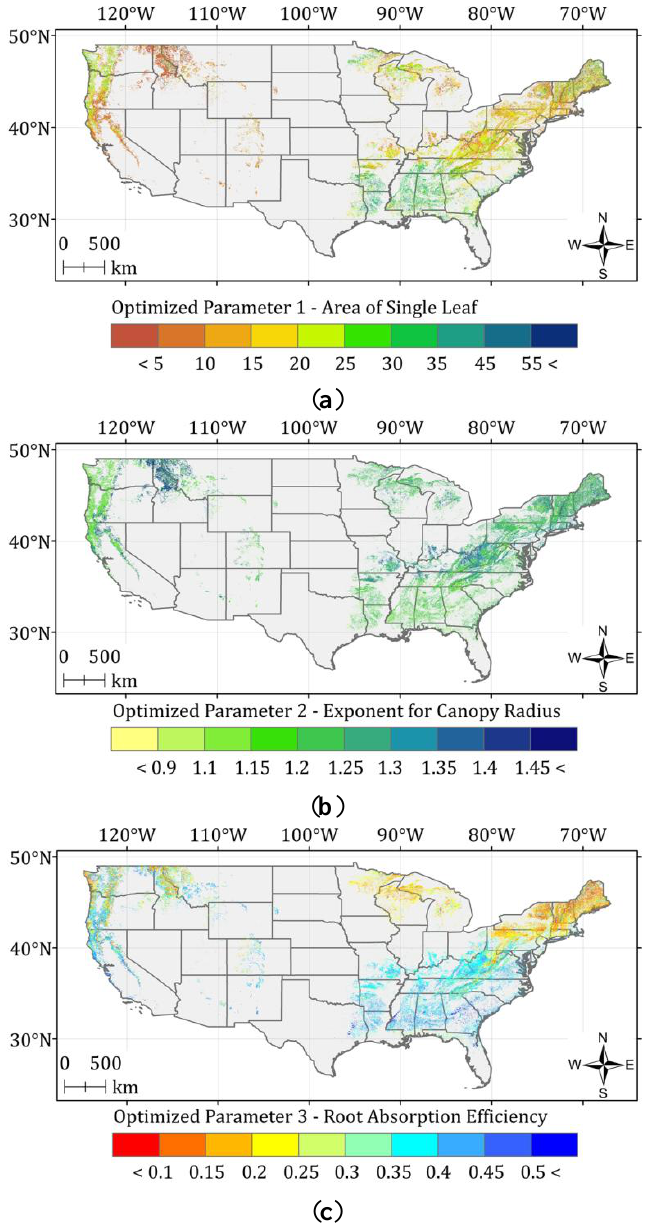
Figure 5. Spatial distribution of the three parameters selected for model optimization